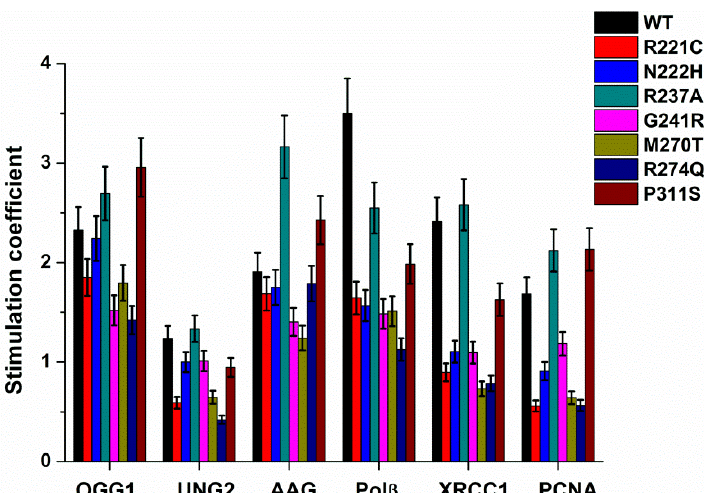
Figure 3. A comparison of stimulation coe ffi cients f of BER proteins between APE1 WT and its SNP variants. The stimulation coe ffi cient is computed according to Equation (2). [WT APE1 or SNP variant] = 10 nM, [FRET-F substrate] = 1.0 µ M, [e ff ector protein (AAG, OGG1, UNG2, Pol β , PCNA, or XRCC1)] = 1.0 µ M.